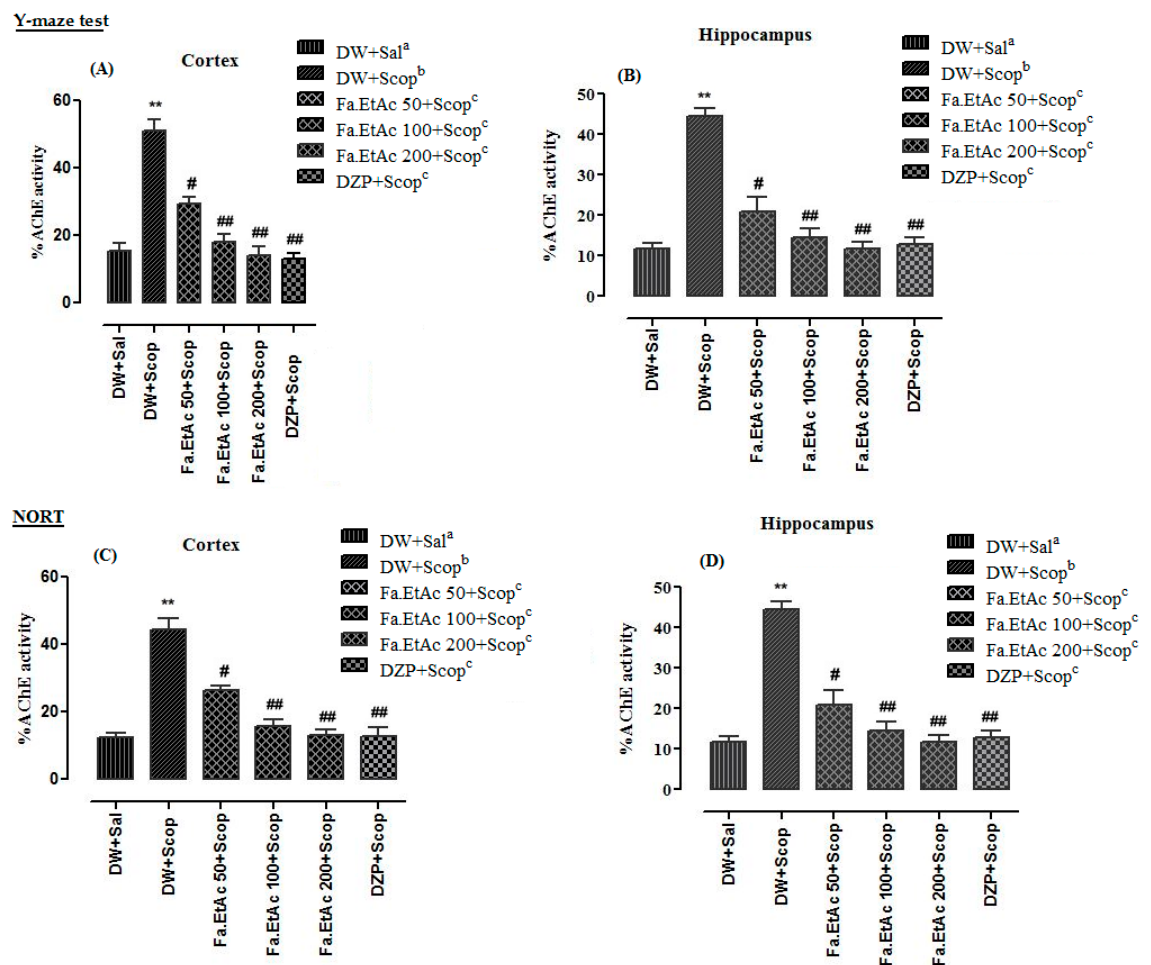
Figure 6. Ex vivo % AChE activity in the ( A ) frontal cortex and ( B ) hippocampus of different animal groups in Y-maze behavioural test and ( C , D ) NORT. The data are expressed as Mean ± SEM; each value corresponds to a mean of eight animals. One-way ANOVA followed by Dunnett’s post hoc multiple comparison test to determine the values of p . ** p < 0.01; comparison of DW + Sal a (Normal control) vs. DW + Scop b (Scopolamine treated), # p < 0.05 and ## p < 0.01; comparison of (DW + Scop) b vs. DZP + Scop c (Donepezil treated) and Fa.EtAc c (50, 100 and 200 mg/kg)-treated groups), ns: values not significantly different in comparison to (DW + Scop) b -treated group using one-way ANOVA followed by Dunnett’s post hoc multiple comparison